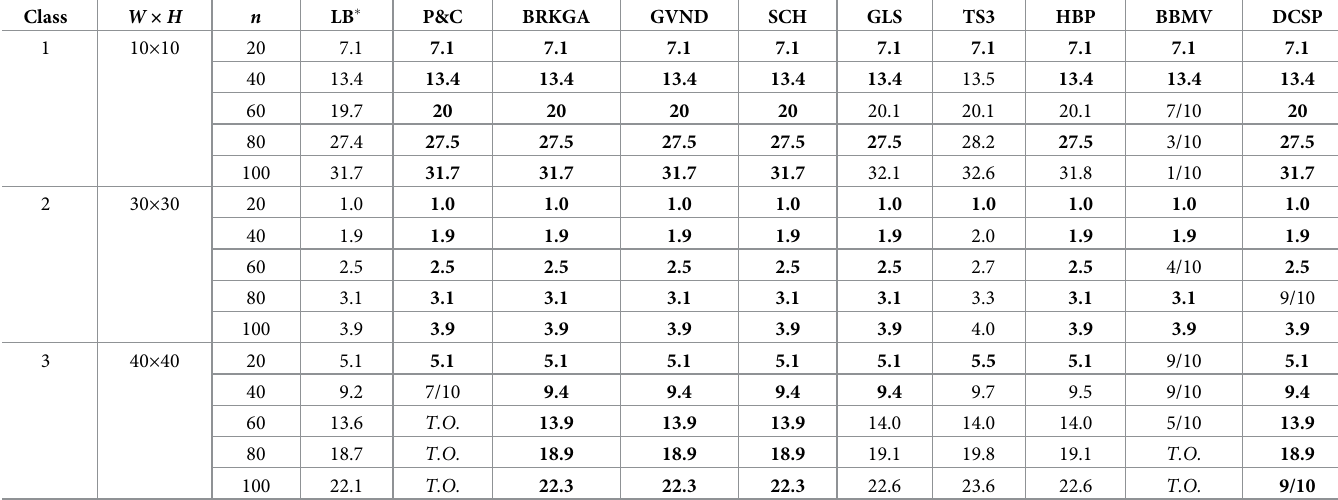
Table 10. Comparison of the solutions obtained by the different approaches for the bwmv instances without rotations. Class W × H n